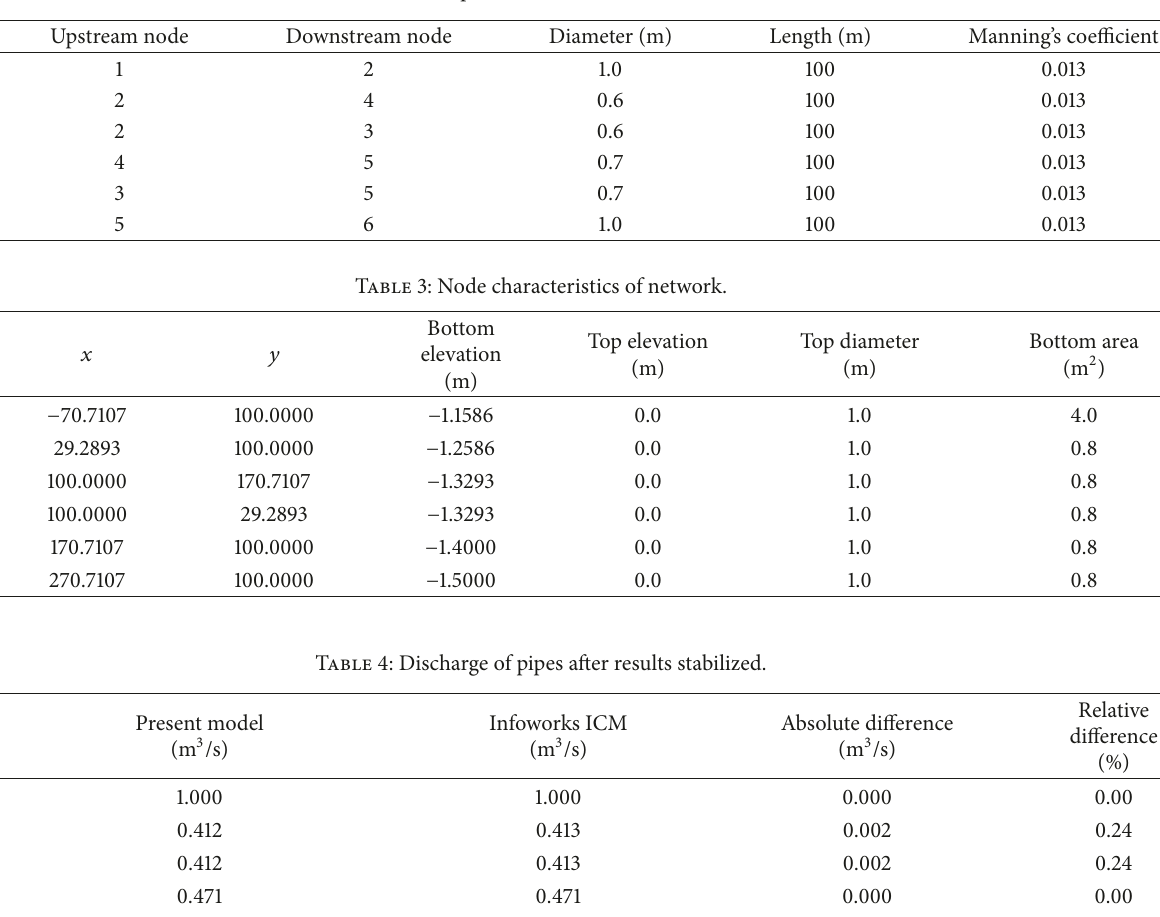
Table 2: Pipe characteristics of network.